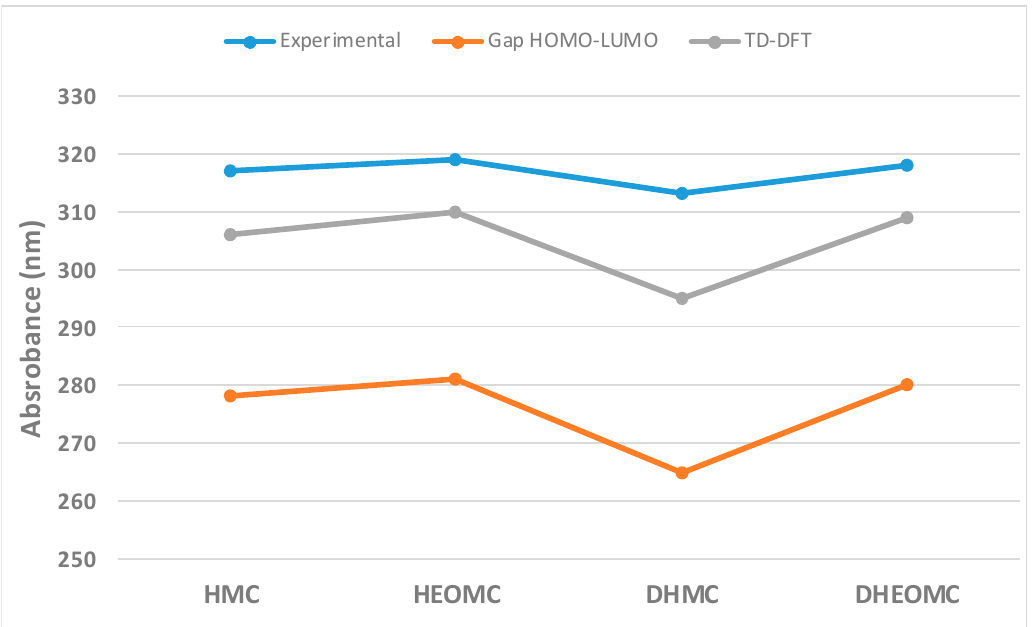
Figure 6 . Comparison between experimental UV-Vis absorption peaks and calculated HOMO–LUMO gap at gas-phase and aqueous phase for C7-substituted coumarins.